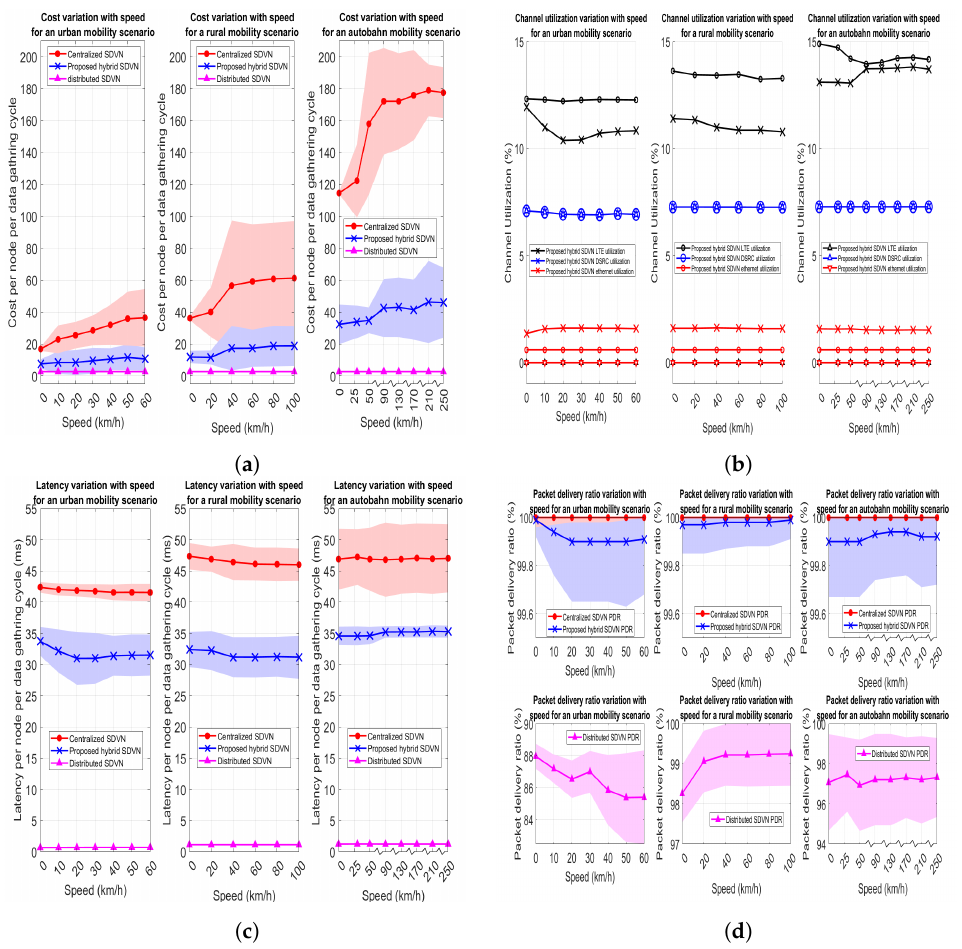
Figure 10. Performance evaluation of the data collection methods under different mobility